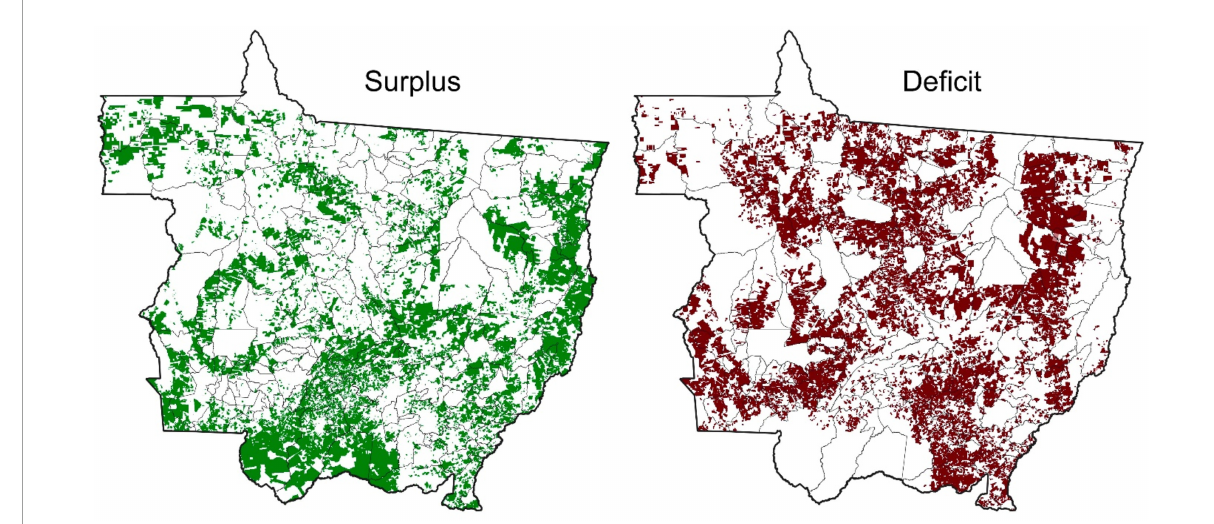
FIGURE11 Maps of native vegetation surplus (left) and deficit (right) .